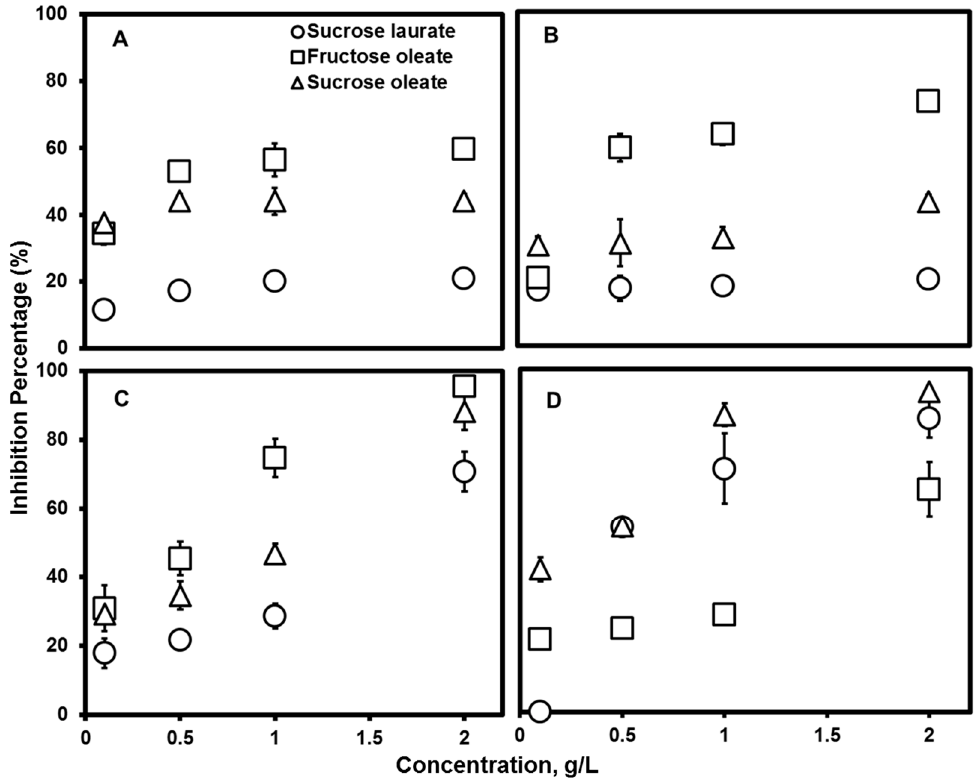
Figure 4. Antimicrobial activities of sugar fatty acid esters: sucrose oleate ( ○ ), fructose oleate ( □ ), and sucrose laurate ( ∆ ) against: ( A ) Lactobacillus plantarum ; ( B ) Pediococcus pentosaceus ; ( C ) Bacillus subtilis ; and ( D ) Staphylococcus aureus .